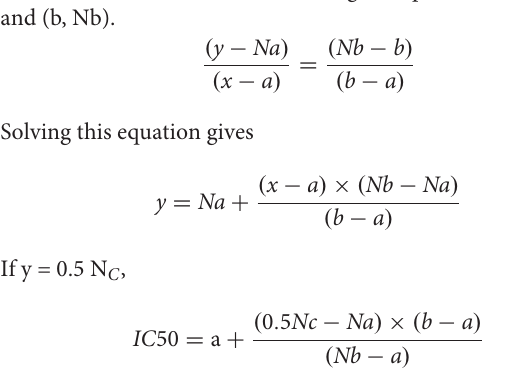
The cell densities of the two given points were (a, Na) and (b,